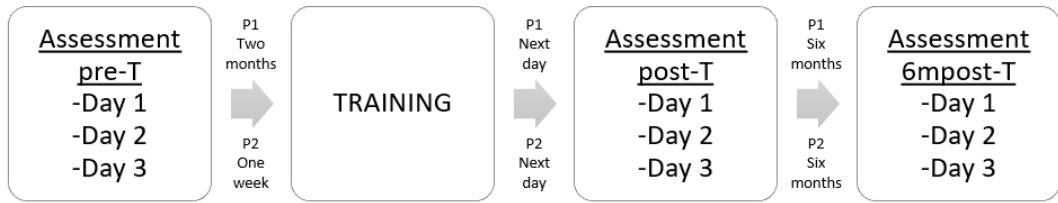
Figure 1. Outline of the study.